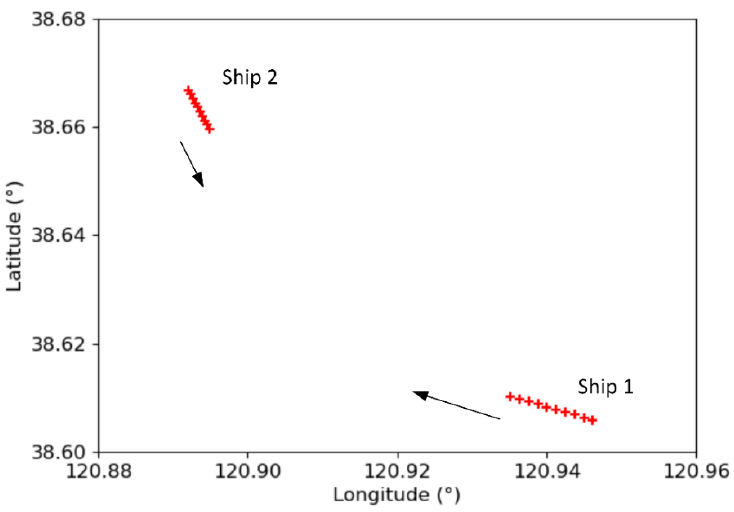
Table 3. The danger sector after changing Ship 1′s manoeuvrability in a head-on scenario.